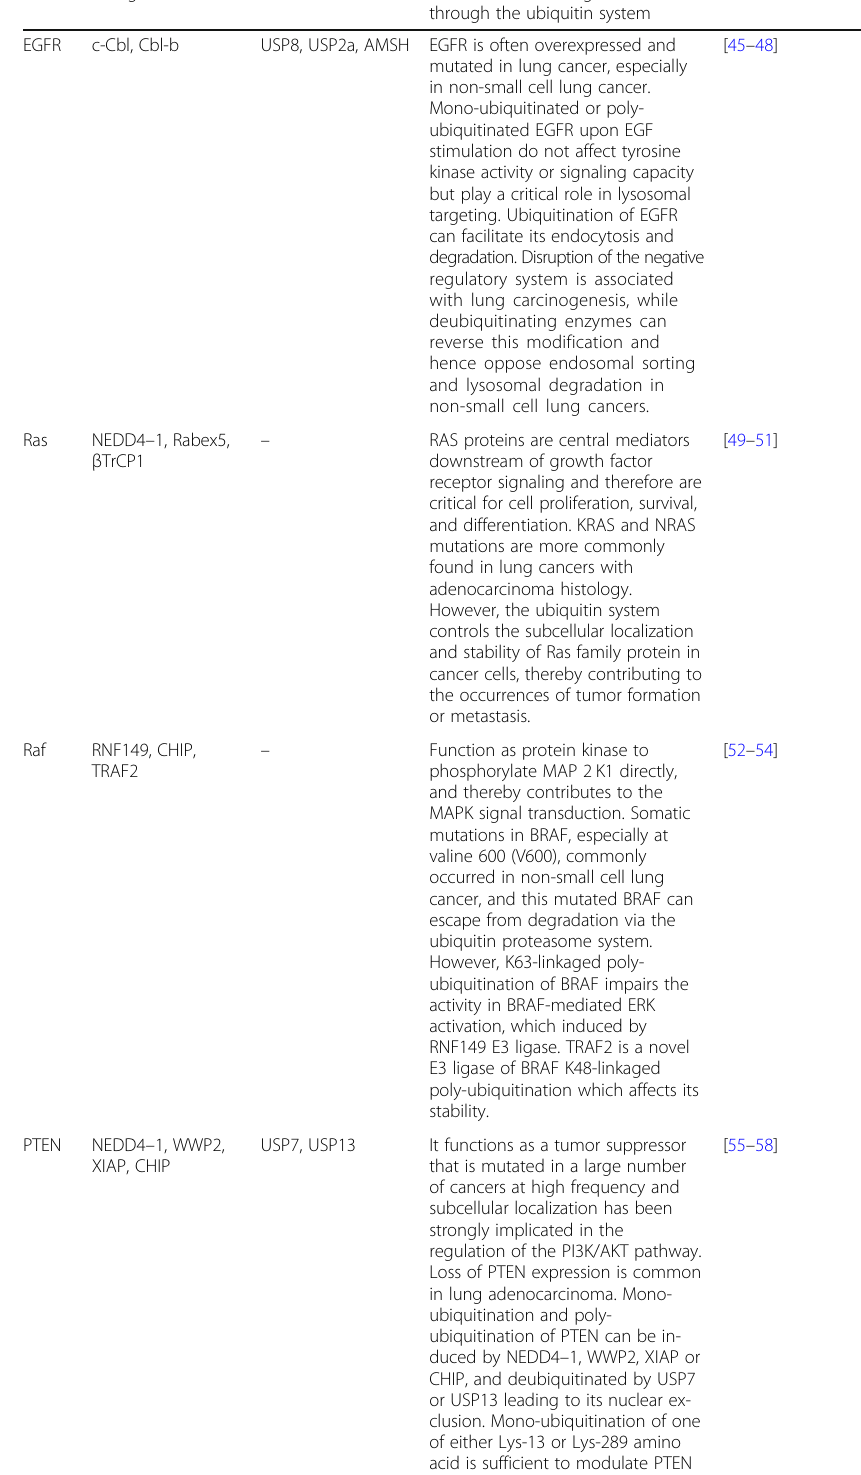
Table 1 A list of ubiquitin E3 ligases and deubiquitination enzymes that have been found in regulation of associated genes in